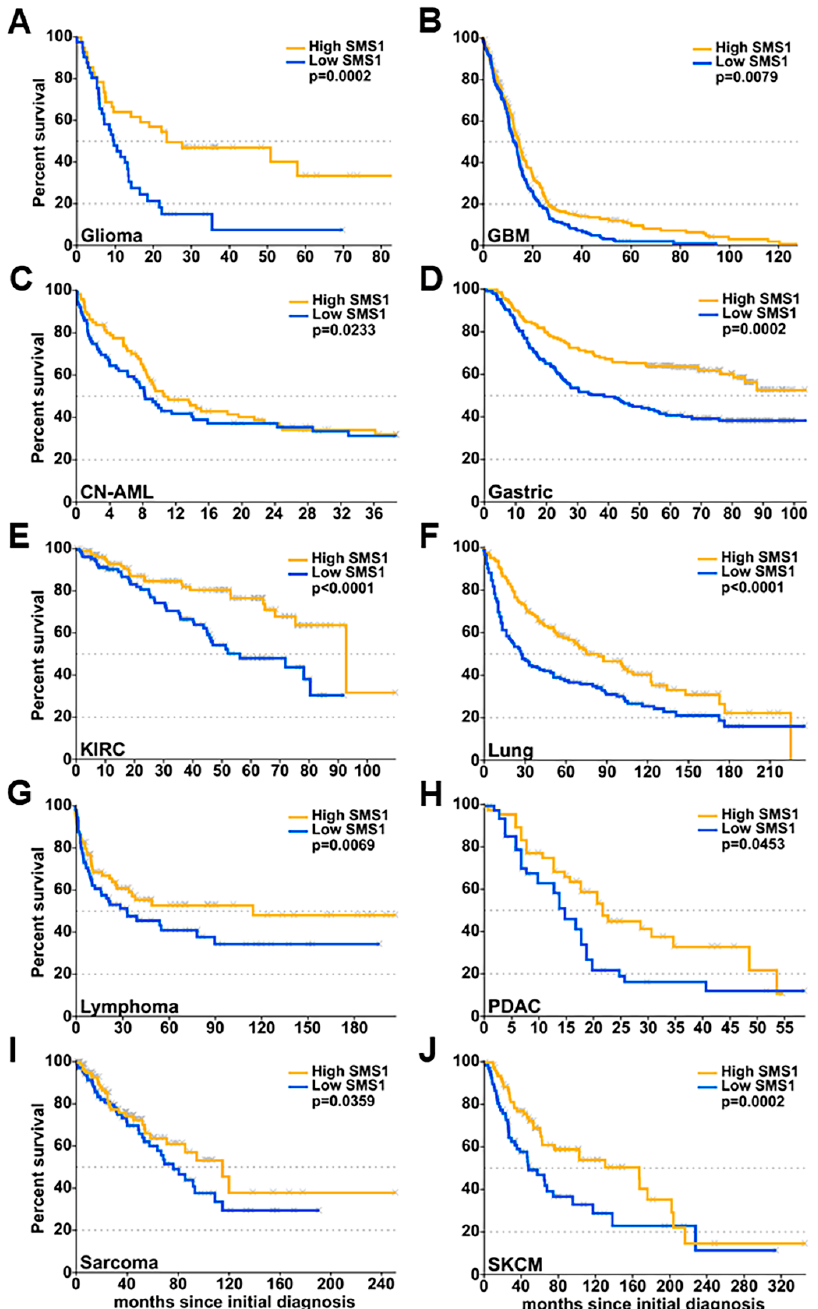
Figure 2. SMS1 expression and overall survival in patients with different types of cancer. Kaplan-Meier plots representing overall survival as a function of SMS1 expression measured in biopsies from patients with ( A ) glioma (grade III and IV, from the GSE4412 database; n = 83), ( B ) glioblastoma multiforme (GBM; n = 542), ( C ) cytogenetically normal acute myeloid leukemia (CN-AML; n = 163), ( D ) gastric cancer ( n = 299), ( E ) kidney renal clear cell carcinoma (KIRC; n = 234), ( F ) lung cancer ( n = 282), including NSCLC (non-small cell lung cancer) and SCLC (small cell lung cancer), ( G ) lymphoma (B-cell lymphoma and Burkitt’s Lymphoma; n = 158), ( H ) pancreatic ductal adenocarcinoma (PDAC; n = 102), ( I ) sarcoma ( n = 234), or ( J ) skin cutaneous melanoma (SKCM; n = 163). For each data set, patients’ cancer samples were classified as high- and low-expressing tissue if the SMS1 expression was higher or lower than the median expression. The p values from the log-rank tests comparing the two curves are shown in each figure. n: number of patients in each data set.